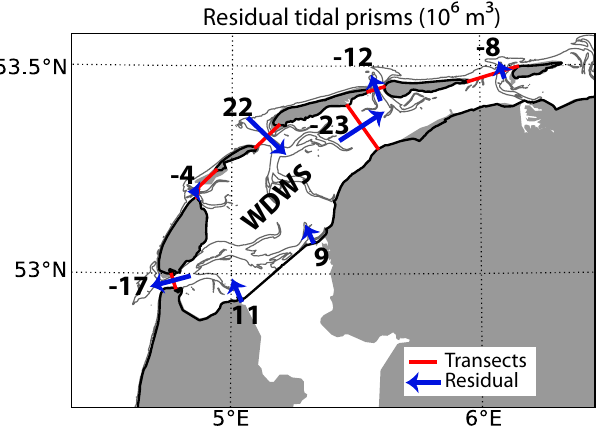
Figure 11. Average residual tidal prisms (flood − ebb) (10 6 m 3 ) of each inlet and the Terschelling watershed. The average input of fresh water per tidal period through the Den Oever and Korn- werderzand sluices is also presented. The numbers (in 10 6 m 3 ) and the length of blue arrows represent the magnitude of the residual tidal prism. The direction of the arrow represents the direction of the average residual tidal prism. The red lines mark the position of the transects used to compute the tidal prisms and transport.